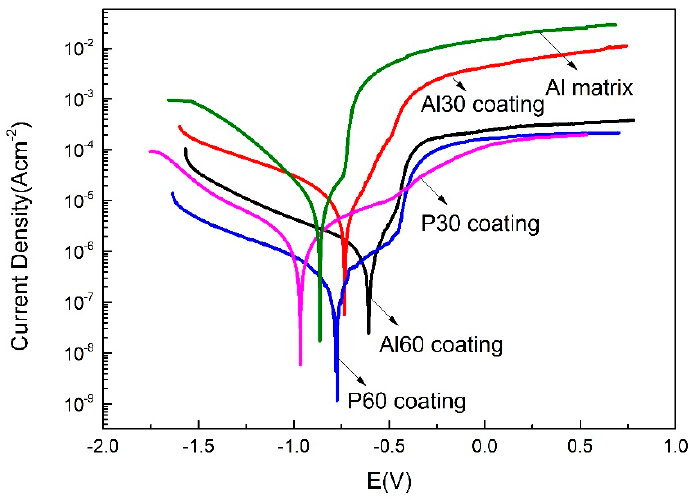
Figure 11. Friction coefficient as a function of sliding time under different loads for Al60 coating.